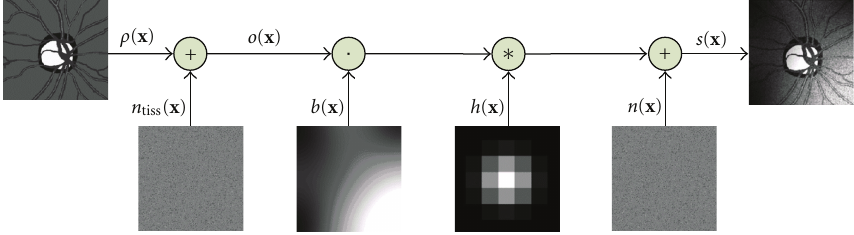
Figure 1: Model of image acquisition. Ideal image is corrupted by noise, multiplicative illumination, and finite resolution of the imaging device (characterized by Gaussian point spread function).